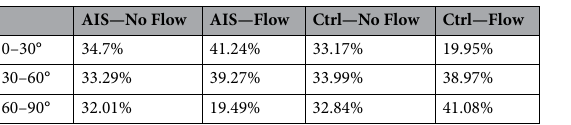
Table 1. The distribution of α angle in control and AIS osteoblast with or without flow